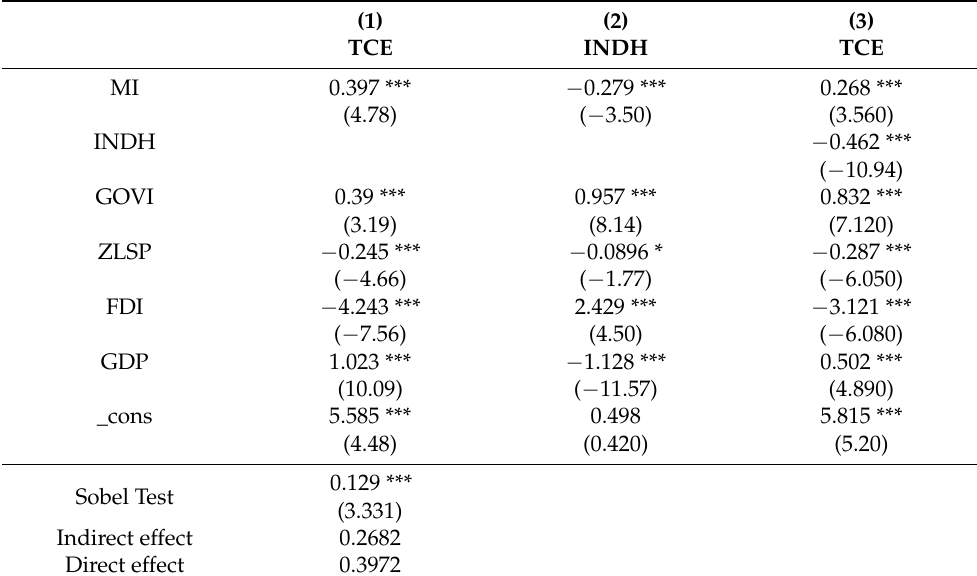
Table 3. Results of mediating effects of industrial upgrades.